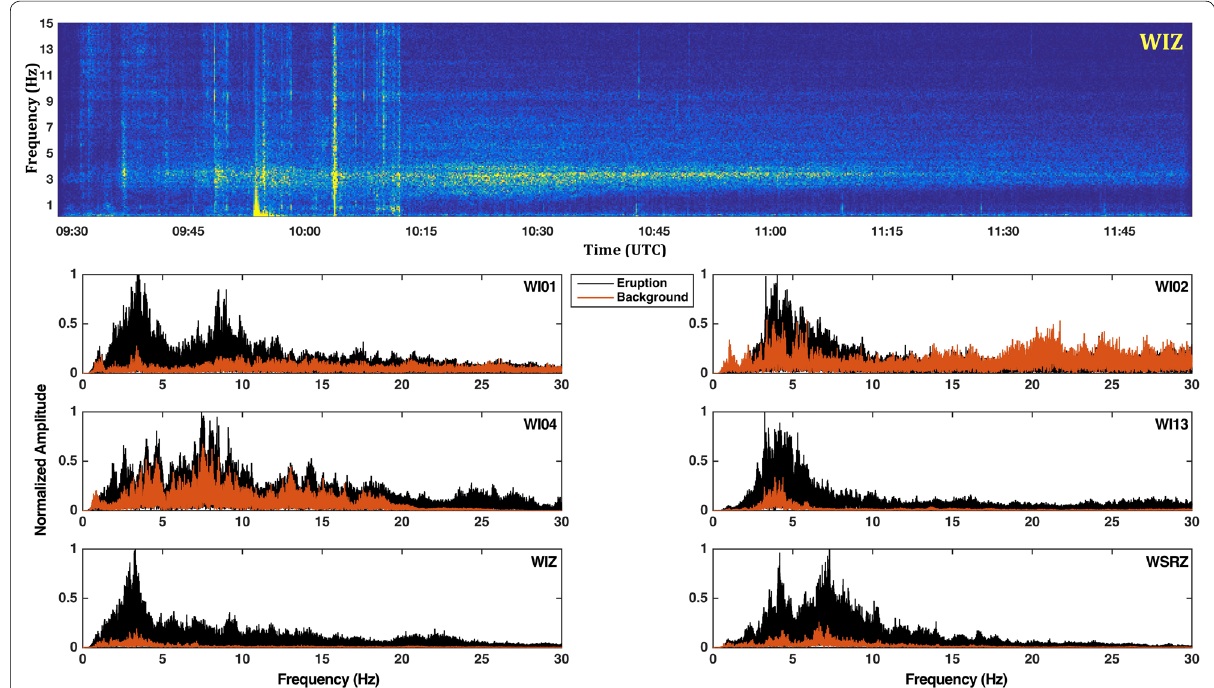
Fig. 5 Seismic spectrogram for the eruption event (station WIZ) along with amplitude spectra for each of the seismic stations. The eruption spectra (black) are overlain by pre-event noise (orange) for background noise comparison